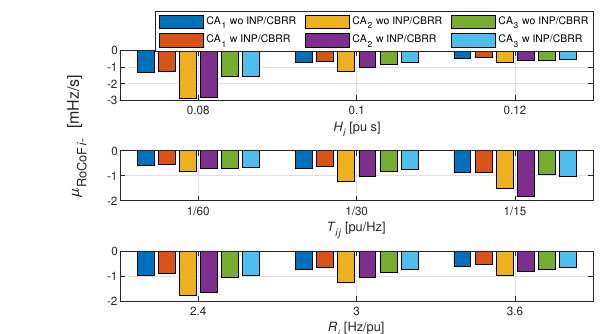
( right ) for different values of H i , T ij and R i , i −